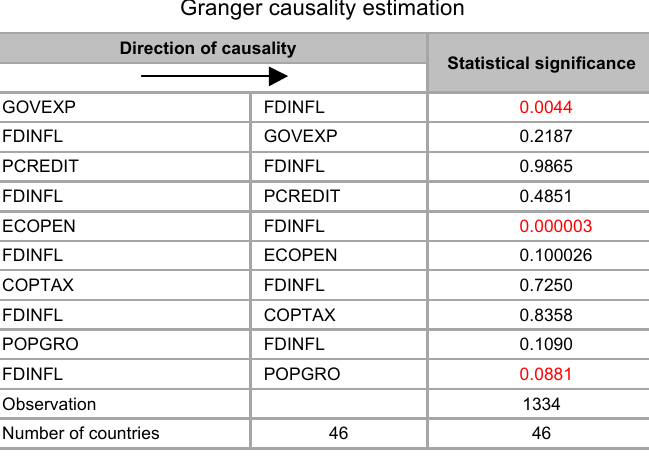
Granger causality